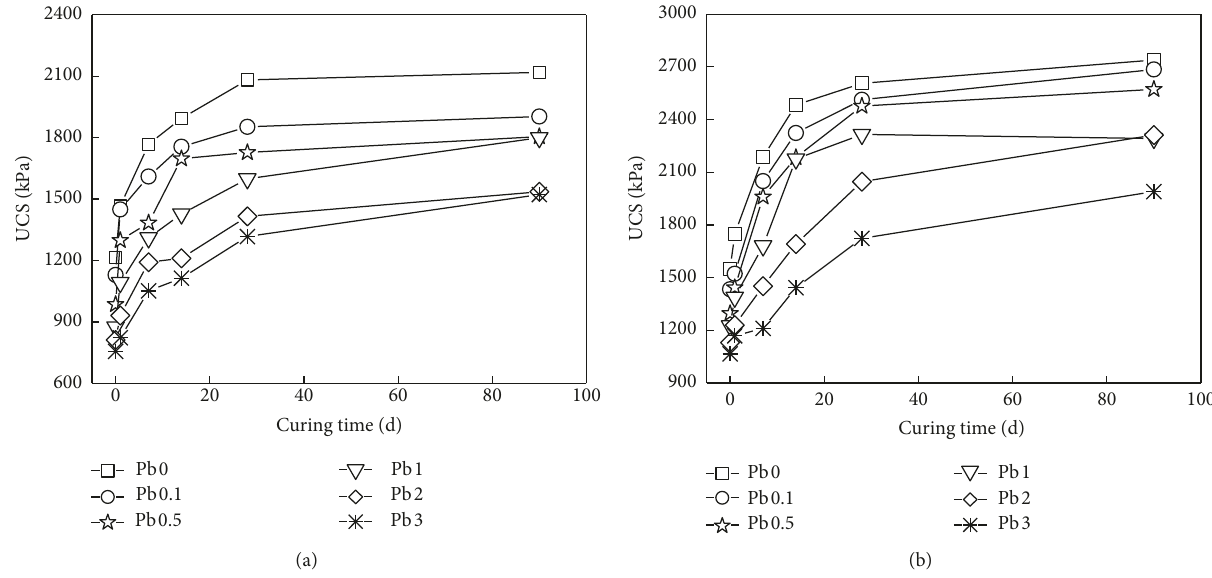
Figure 4: Evolutions of the UCS with the curing time of the specimen. Alkaline residue contents of (a) 10% and (b)